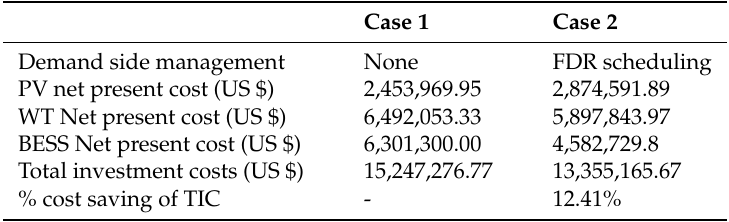
Table 3. Investment costs per component and total system cost comparison for cases without and with DSM strategy